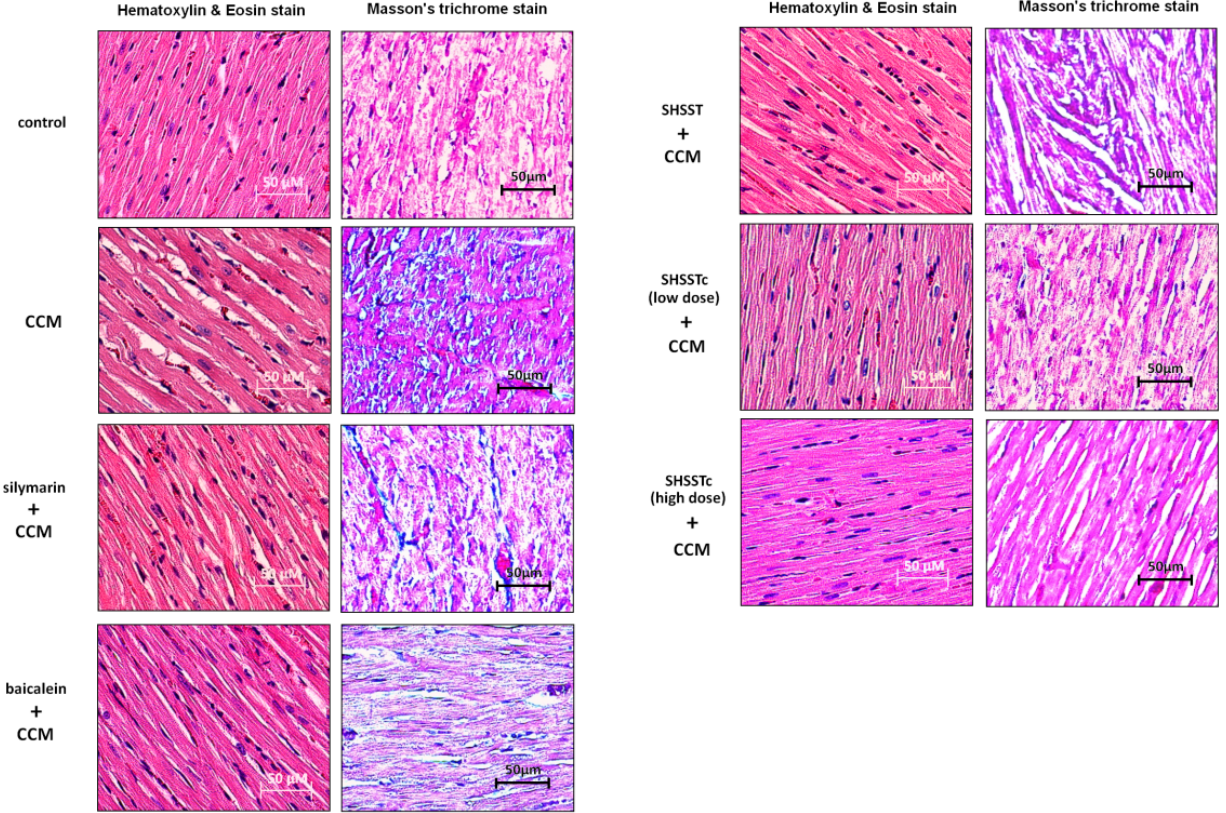
Figure 2. Morphology assessments by hematoxylin and eosin (H&E) stain, Massion’s trichrome stain (MS) assay in cirrhotic cardiomyopathy (CCM) rat hearts. In H&E stain slides, cell nuclei are stained with blue color, other intracellular or extracellular protein are stained with pink color. The heart fibrosis can be assessed using the collagen accumulation (indicated by blue color). Normal cells are indicated by pink color in the MS assay. All heart sections were obtained from the ventricular septal of each